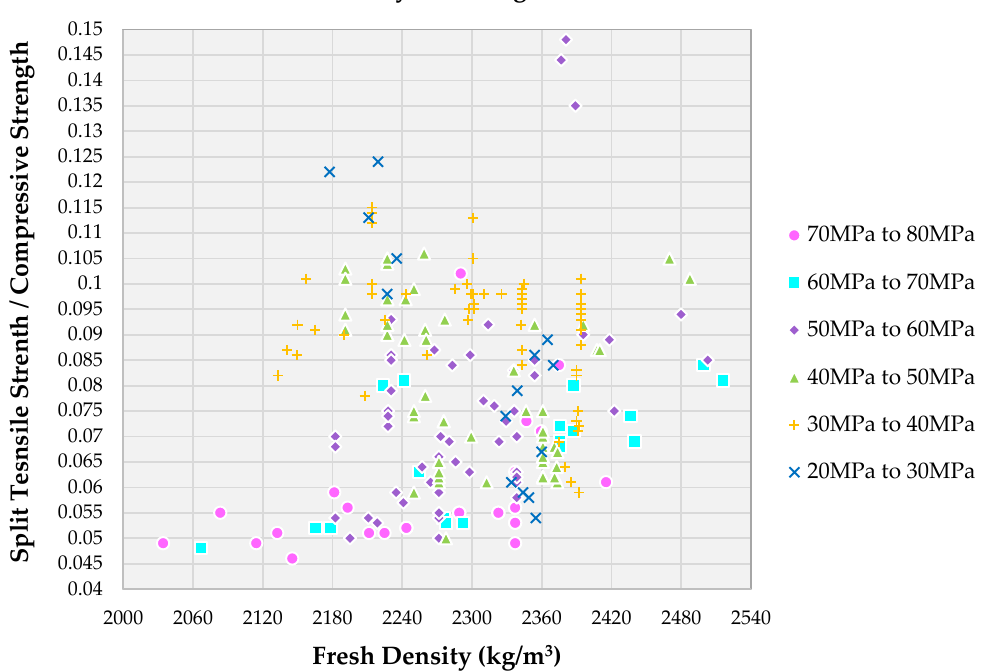
Figure 12. Effect of fresh density on various compressive strength of SCC concrete with recycled aggregate according to literature.